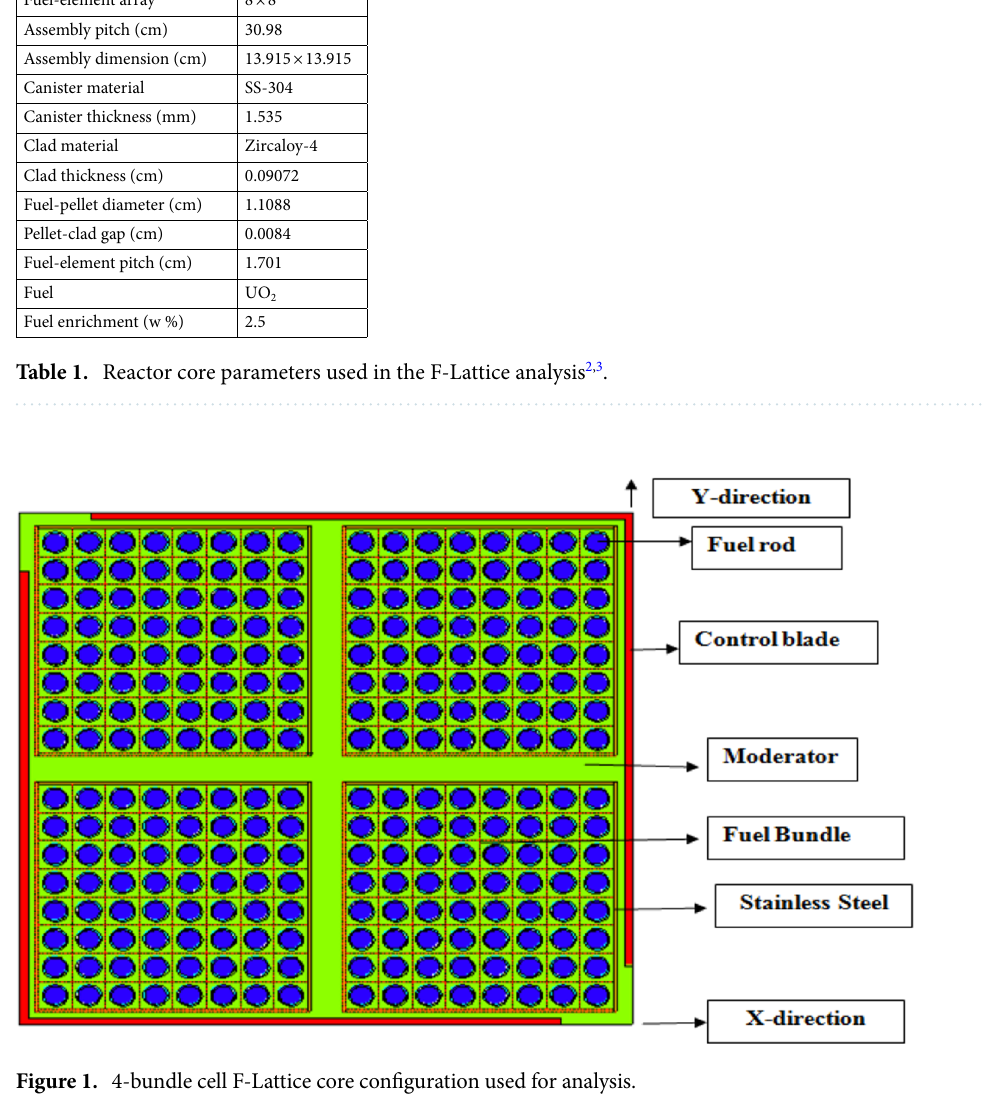
Figure 1. 4-bundle cell F-Lattice core configuration used for